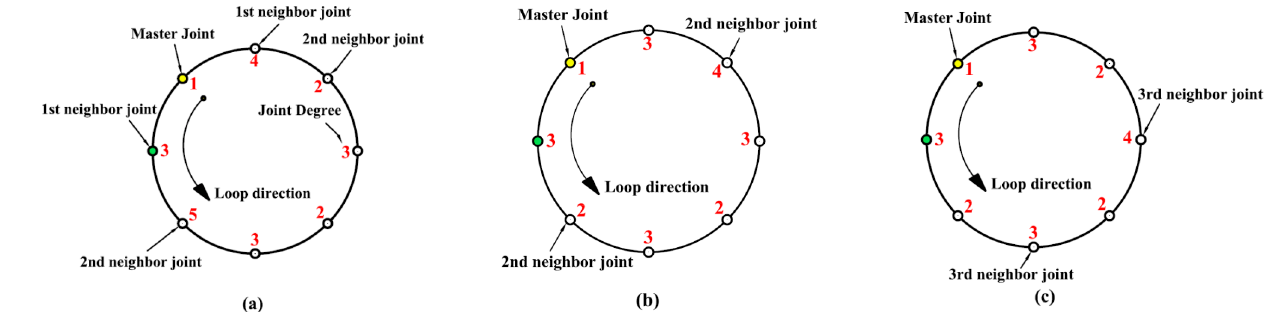
Figure 3. Examples for loops that have a single master joint. ( a ) non equal 1st neighbor joint degrees. ( b ) equal 1st neighbor joint degrees. ( c ) equal 1st and 2nd neighbor joint